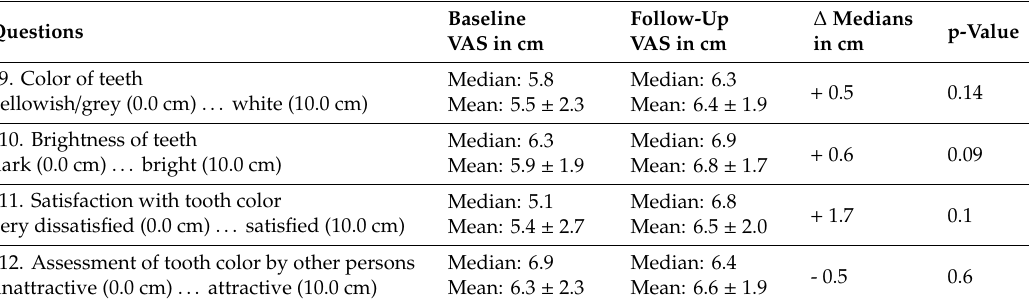
Table 4. Comments of the patients after follow-up (4-week; clustered from free text answers).